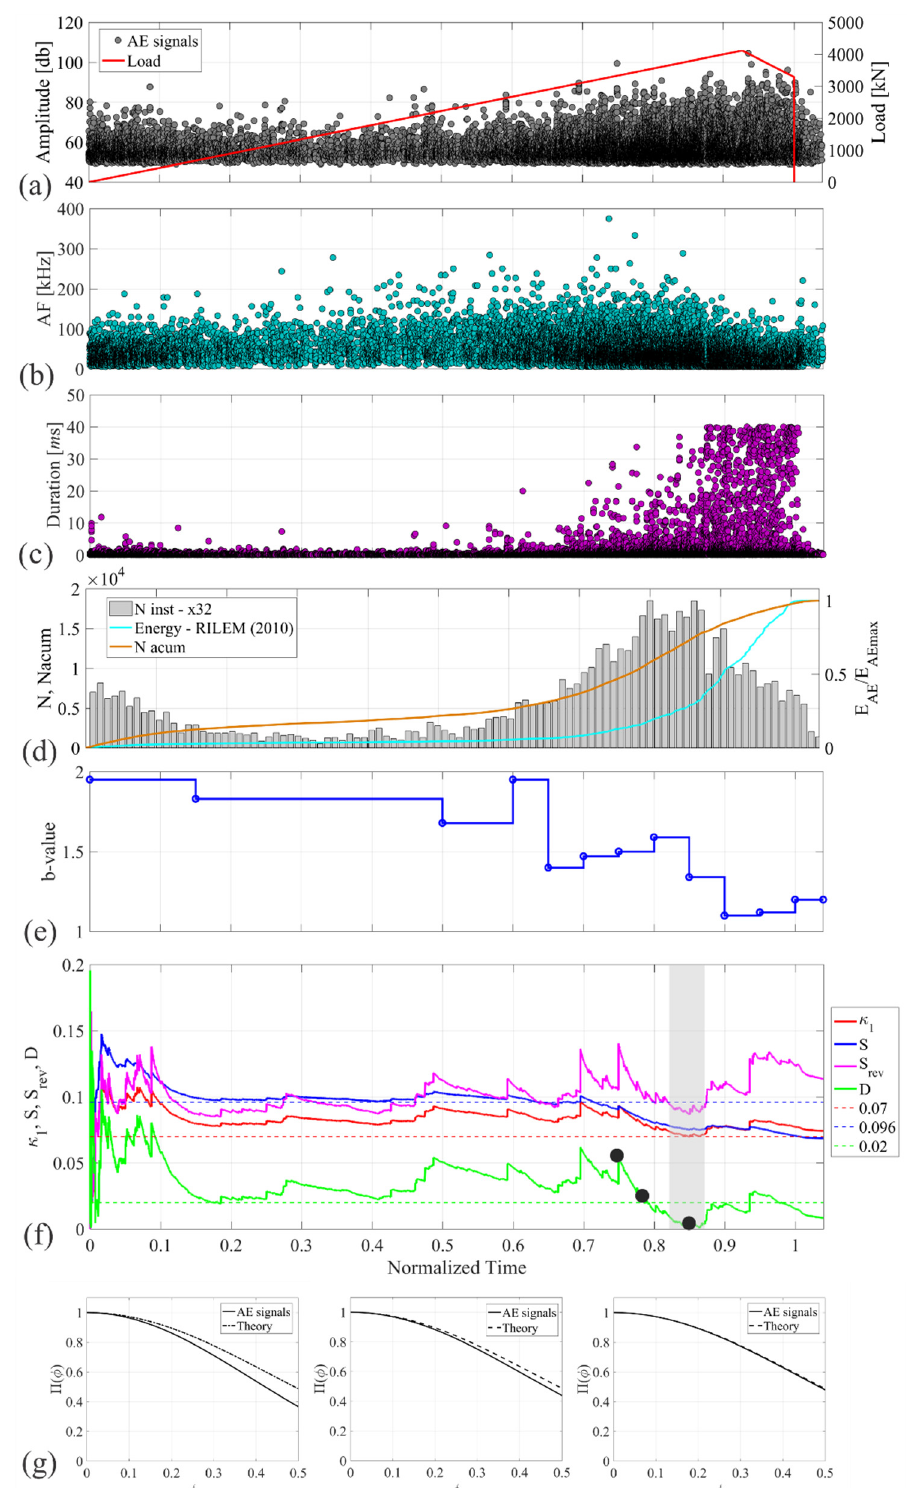
Figure 5. b -value and NT analysis, data from the Lunitek system: ( a ) compressive-load and AE signal amplitudes, ( b ) average frequency ( AF ), ( c ) signal duration, ( d ) instantaneous and accumulated signal counts and normalized AE energy ( E AE ), ( e ) b -value evolution and ( f ) natural time analysis. The horizontal axis is the same for all figures. ( g ) Evolution of Π ( φ ) with AE data from the Lunitek system for the true coincidence instants (black circles in ( f )) in normalized time equal to (from left to right): 0.7492, 0.7877, and